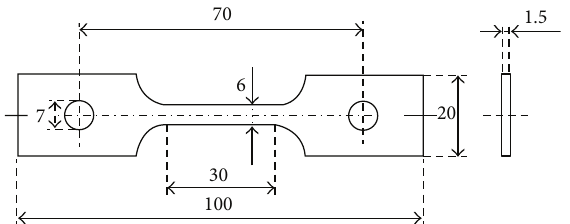
Figure 1: Geometry of the stainless steel specimen in